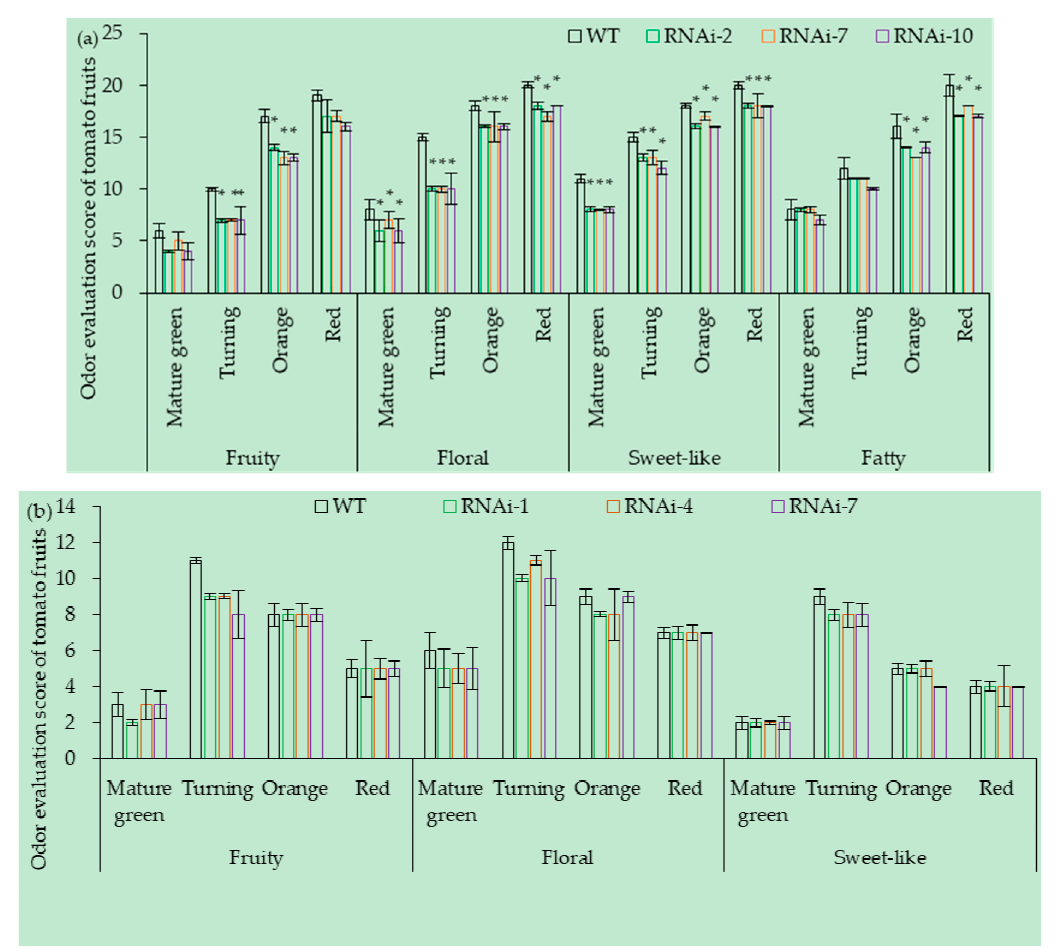
Figure 13. RNAi of SlCCD1A on the aroma scores of tomato fruits ( a ) CI1005 and ( b ) TI4001. WT: pCAMBIA1300 empty vector; * indicates that the aroma score was significantly lower in RNAi lines than in WT ( p < 0.05).